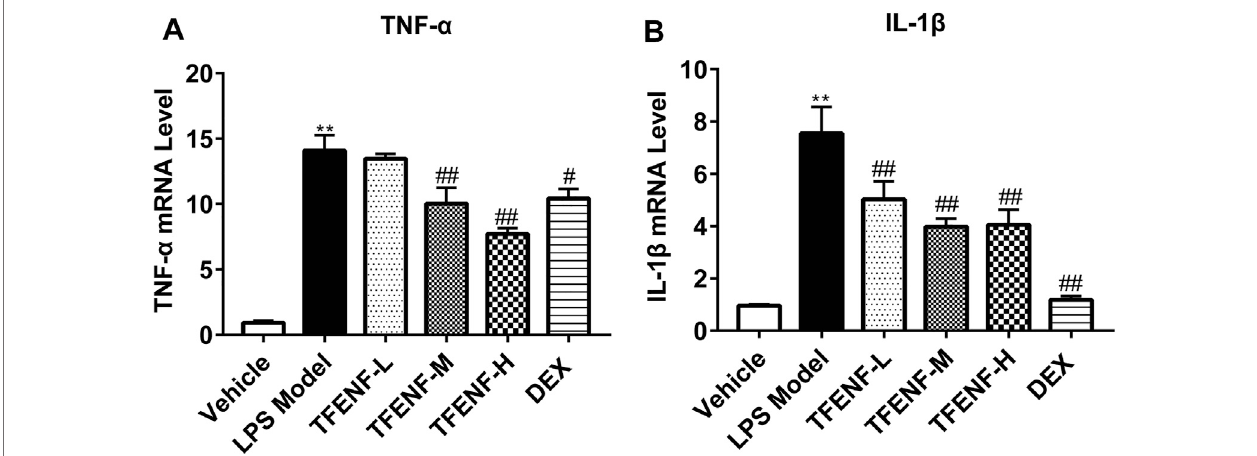
FIGURE5| TFENFsuppressed the expression ofpro-in fl ammatory cytokines inLPS-inducedALI.Measurement ofmRNAlevels ofTNF- α (A) and IL-1 β (B) inlung tissue 6 h after LPS-induced ALI or saline treatment ( n (cid:2) 6 per group). Data are presented as mean ± S.E.M. **p < 0.01 compared with the vehicle group; # p < 0.05 compared with the LPS model group; ## p < 0.01 compared with the LPS model group.